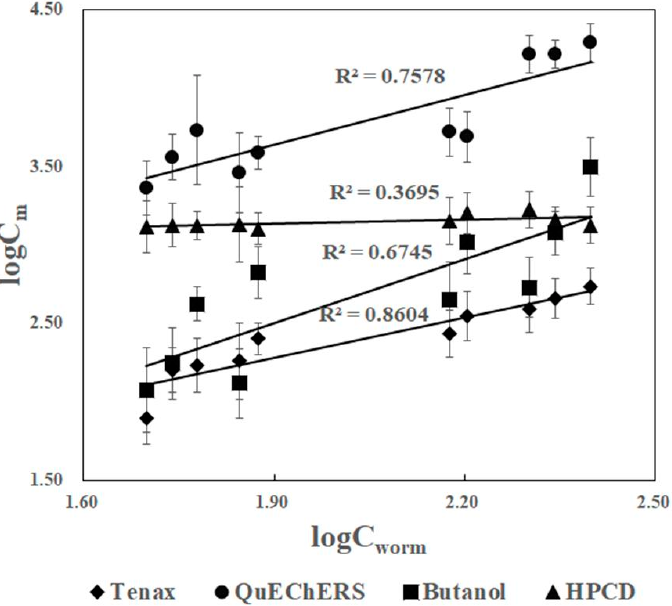
Figure 3. Correlation of oxyfluorfen accumulation in earthworms and extracted from soil by different chemical extraction methods. Data are expressed as the mean values ± SE (standard error).